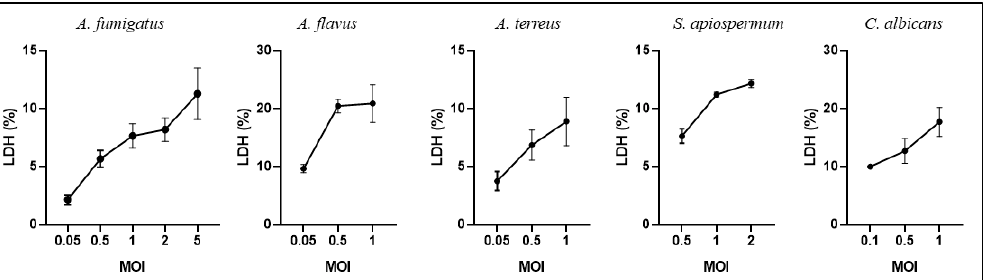
Figure 1. Cytotoxicity of fungal species as measured with LDH assay according to the MOI used, following 15 h of infection with each strain of the five species. The data were expressed as a lysis percentage by calculating the ratio of LDH activity measured in the cellular supernatant to total LDH activity (released LDH plus intracellular LDH = 100%) from the same well. Each point represents the mean ± standard error of the mean (SEM) of triplicate of one experiment with each